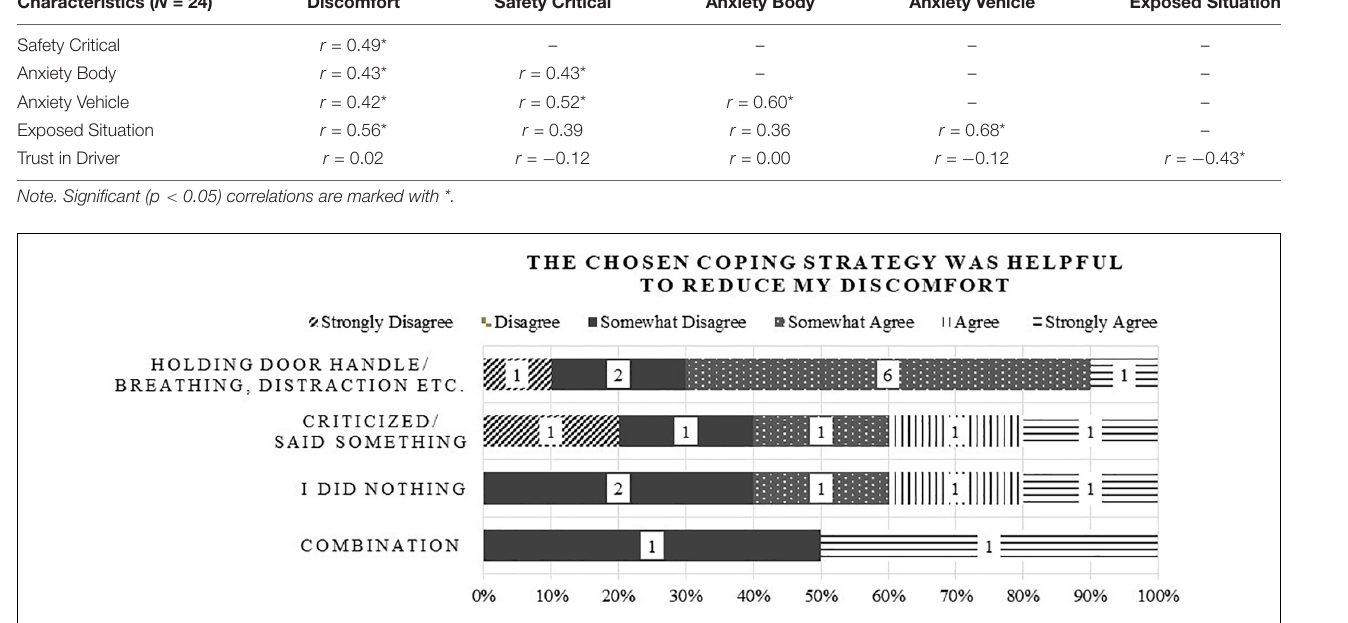
FIGURE 4 | Frequencies of named coping strategy to reduce co-driver discomfort and ratings how helpful they